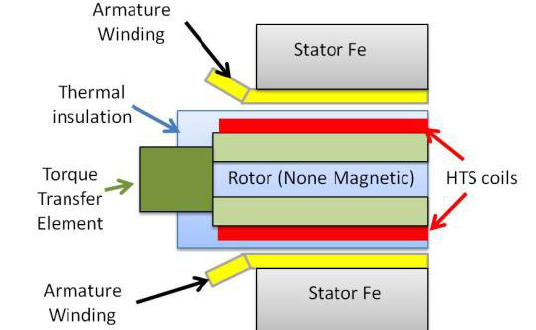
Fig.5 Axial-radial cross section of a superconducting synchronous machine. Reproduced from reference